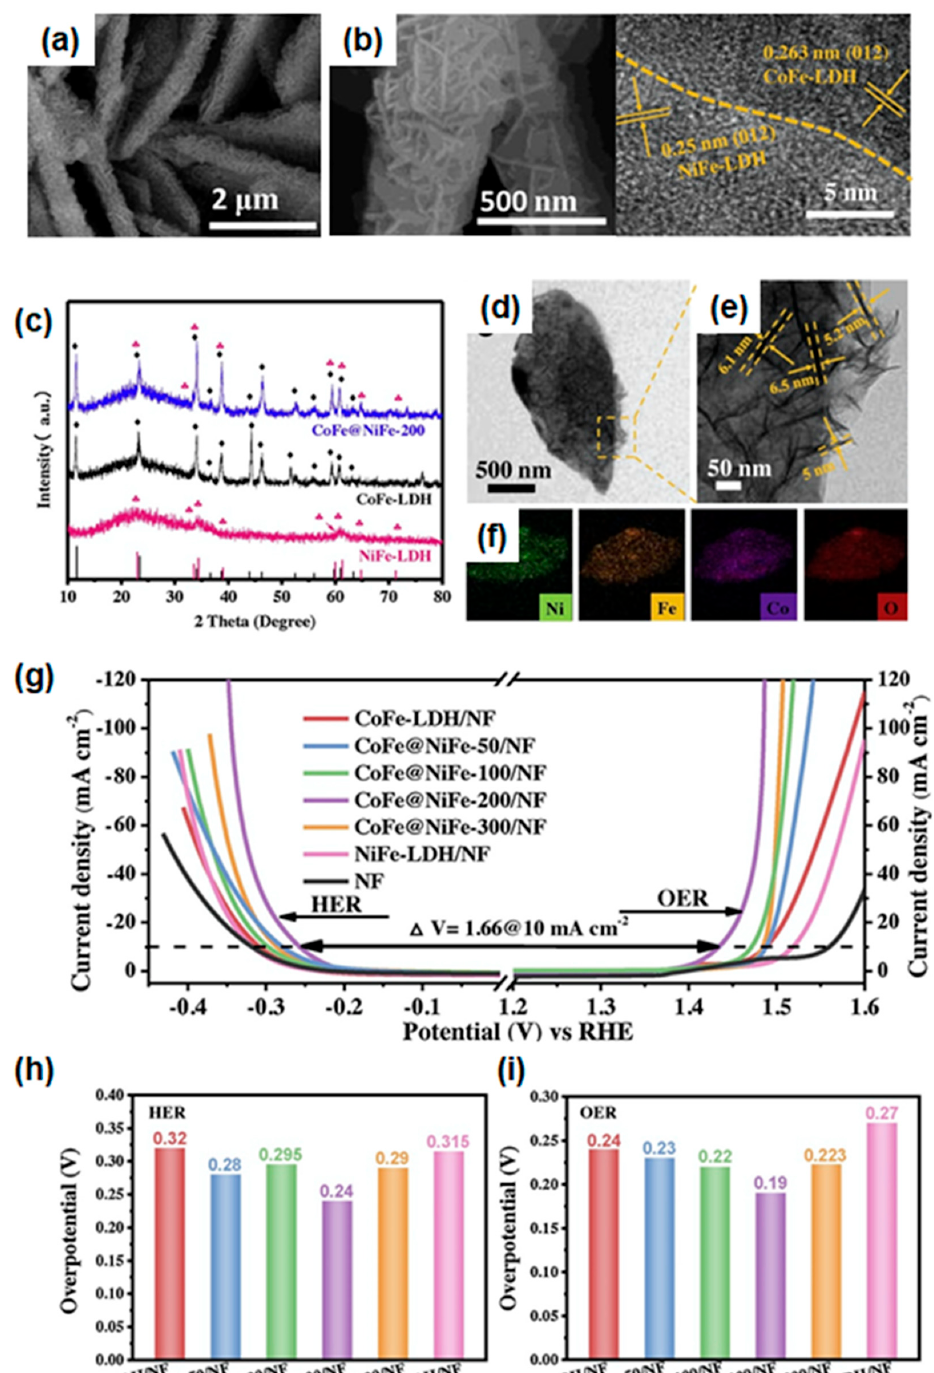
Figure 9. ( a ) SEM images and ( b ) HR-TEM image of CoFe@NiFe-200/NF architecture. ( c ) XRD patterns of CoFe-LDH, NiFe-LDH, and CoFe@NiFe-200. ( d ) TEM, ( e ) magnified TEM, and ( f ) elemental mapping images of CoFe@NiFe-200 architecture. (The symbol of red and black represents NiFe-LDH and CoFe-LDH, respectively). ( g ) Steady-state polarization curves of CoFe-LDH/NF, CoFe@NiFe-50/NF, CoFe@NiFe-100/NF, CoFe@NiFe-200/NF, NiFe-300/NF, NiFe-LDH/NF, and NF in 1.0 M KOH for HER and OER. Overpotential comparison of synthesized catalysts ( h ) for HER and ( i ) for OER at a current density of 10 mA/cm 2 . Reprinted (adapted) from [153], copyright (2023) Elsevier B.V.